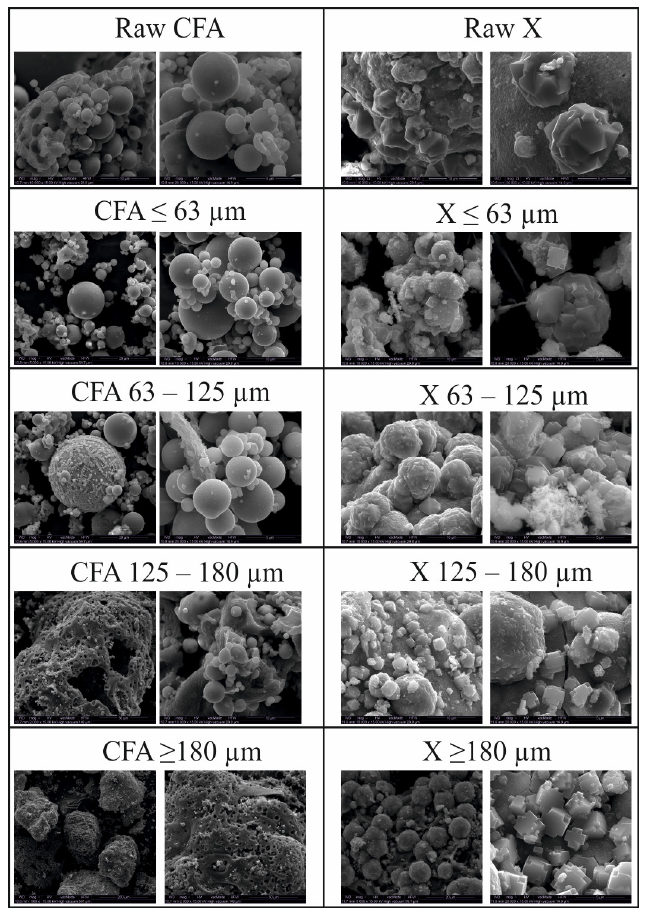
Figure 6. Morphological analyses of raw fly ash, fly ash fractions after sieving and zeolites obtained from them.